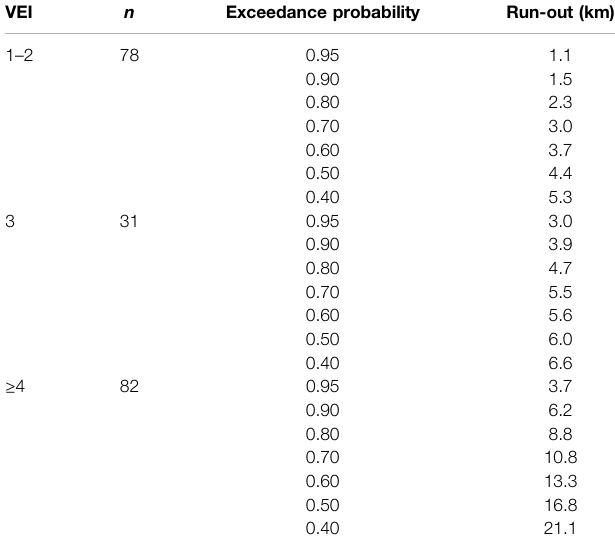
TABLE 2 | Pyroclastic fl ow run-out (in km) exceedance probabilities (given an eruption) for VEI1-2, VEI3 and VEI ≥ 4 from Newhall and Hoblitt (2002), probabilities less than 0.4 are not shown here.